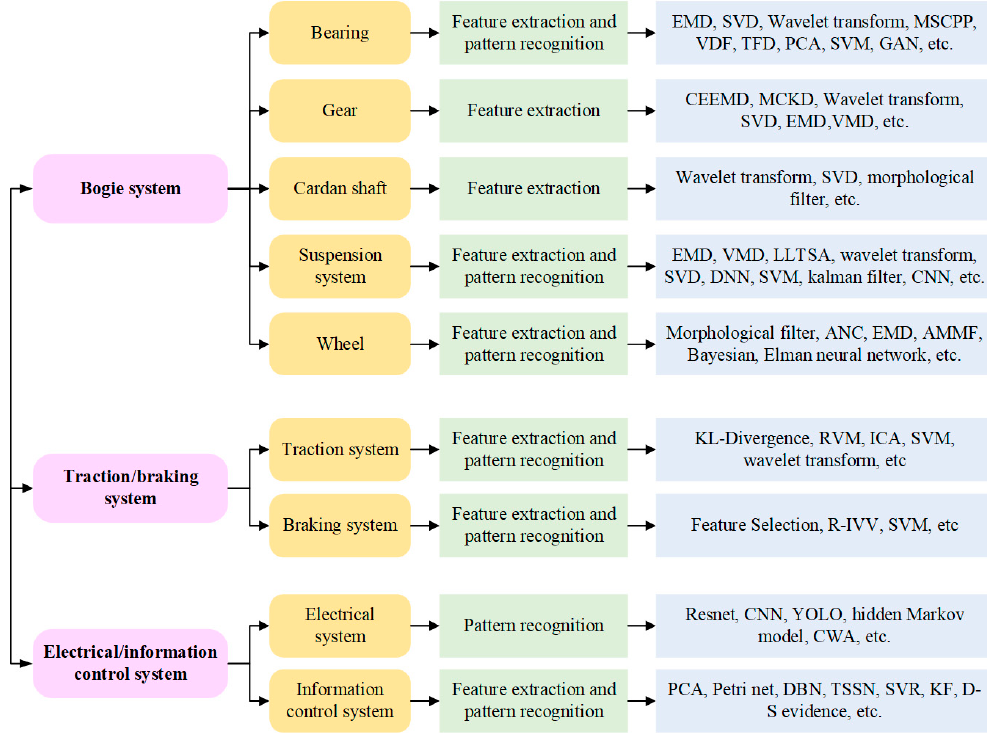
Figure 11. The main fault diagnosis methods used in the key systems of high-speed trains. Table 1. Applicability of main fault diagnosis methods.